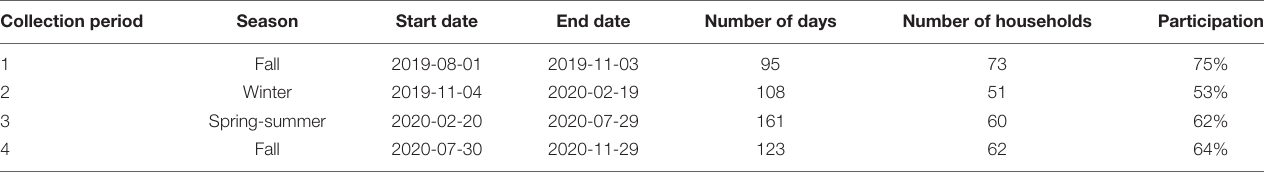
TABLE 1 | Collection period dates and the participation in household lint collection over the course of our study. Collection period